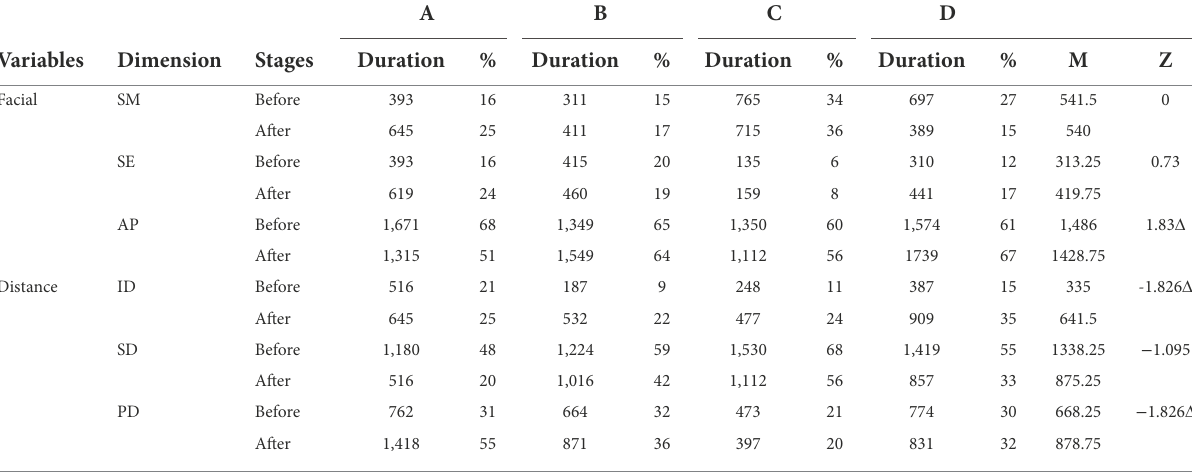
TABLE 5 Description of facial expression and interpersonal distance before and after